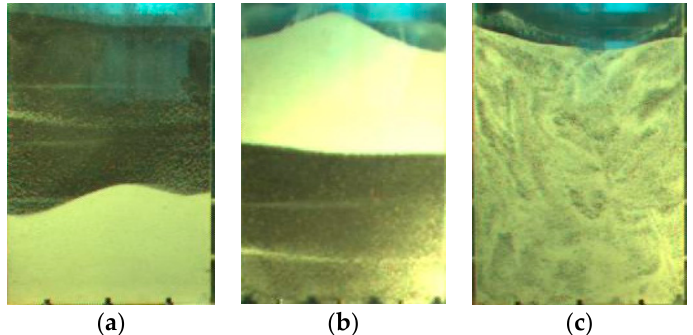
Figure 5. Three different initial packing conditions. ( a ) RA on top, ( b ) RA on bottom, and ( c ) complete mixed state.